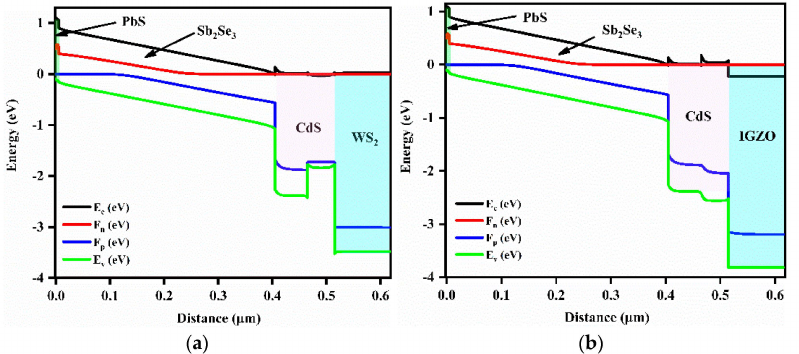
Figure 2. Energy band diagram of ( a ) device having WS 2 and ( b ) device having IGZO as ETLs.